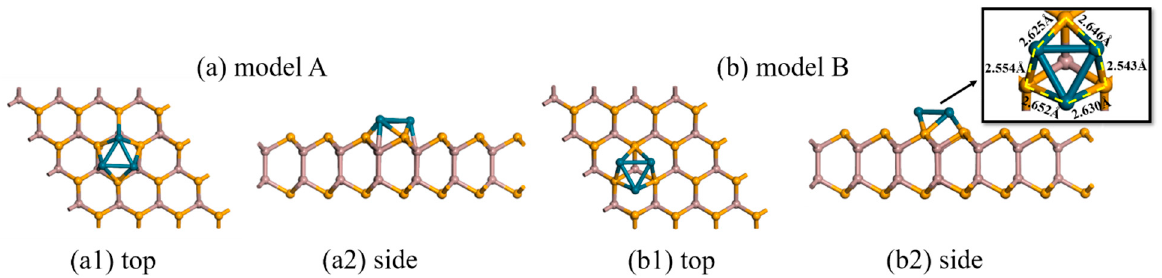
Figure 5. Two geometric models of Pd 3 -GaSe monolayer.